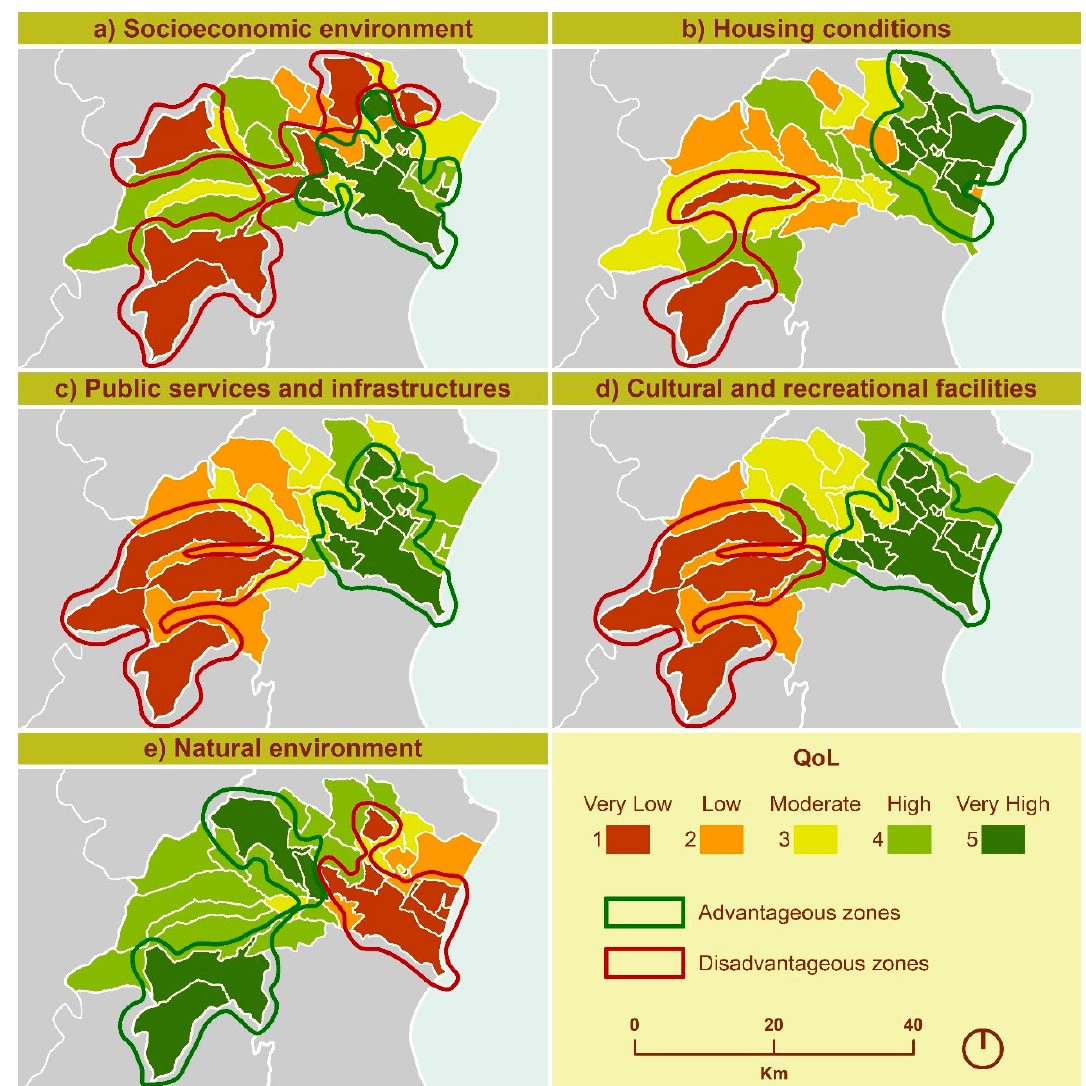
Figure 6. Maps of the QoL criteria, LAUs of Katerini Municipality. ( a ) socioeconomic environment, ( b ) housing conditions, ( c ) public services and infrastructures, ( d ) cultural and recreational facilities, ( e ) natural environment.